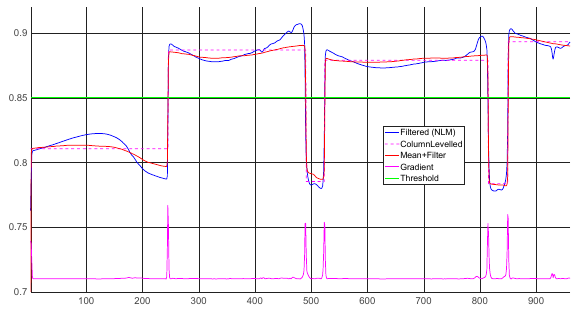
Figure 6. Operation of the technical filter levelling.